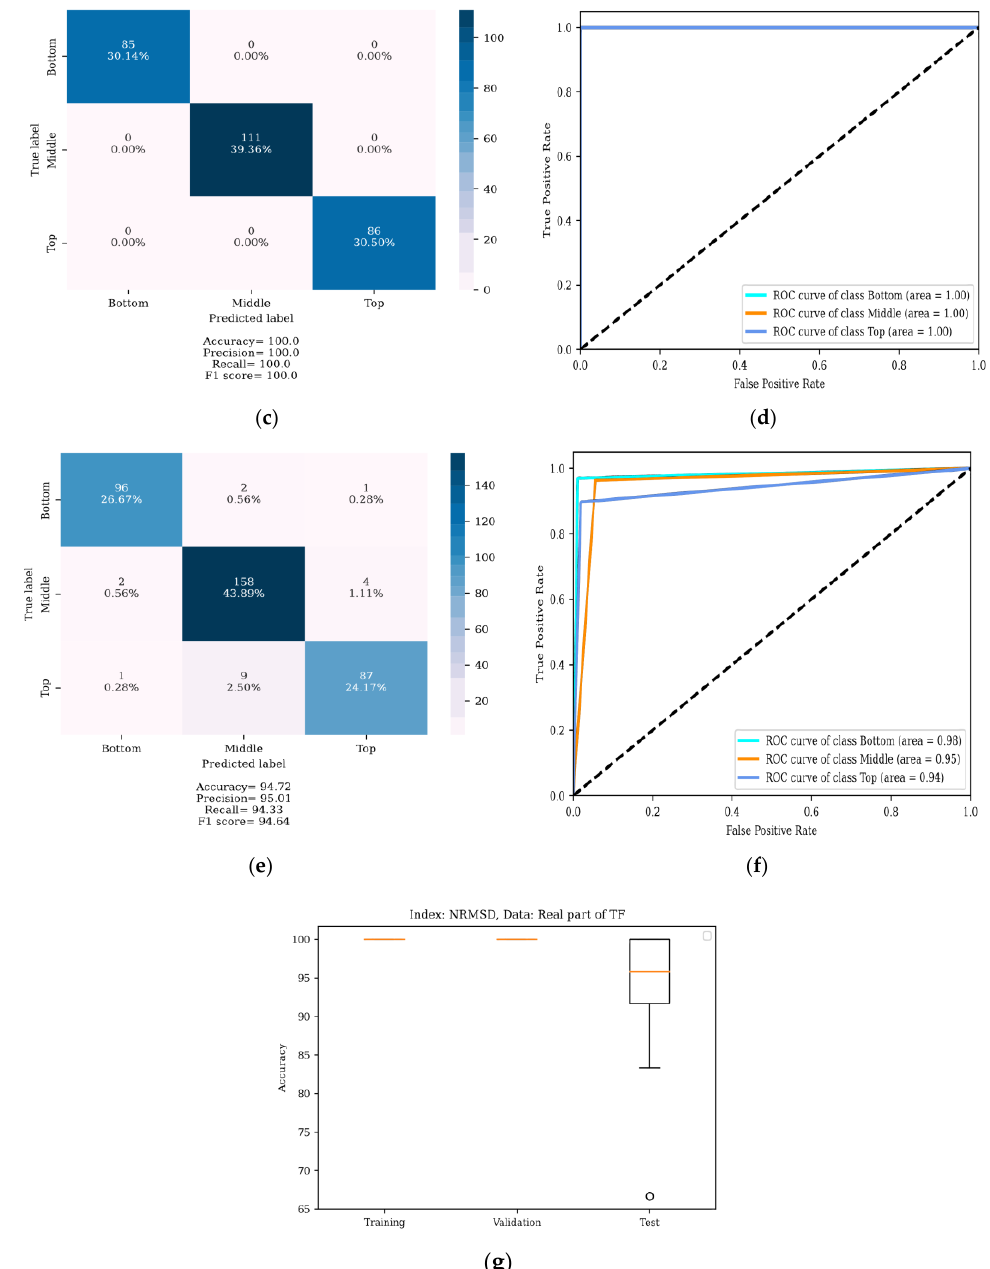
Figure 21. MLP performance in localization of the DSV fault using the extracted features from the real part of the TF using NRMSD index: ( a ) training confusion matrix; ( b ) training ROC curve; ( c ) validation confusion matrix; ( d ) validation ROC curve; ( e ) test confusion matrix; ( f ) test ROC curve; ( g ) box plot of the training, validation, and test accuracies in thirty iterations.